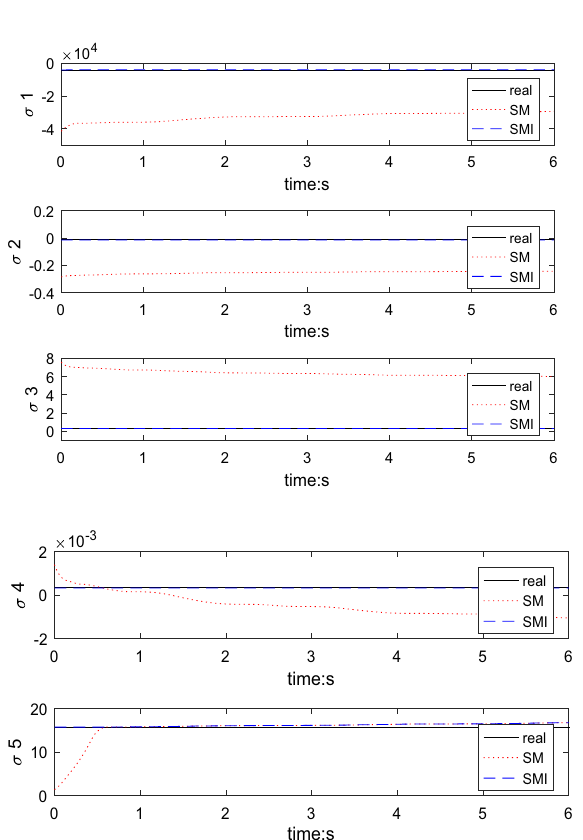
Figure 14. Parameter identification